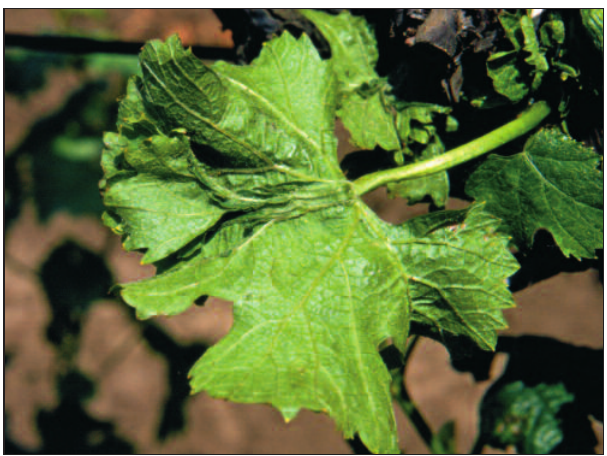
Figure 18. Grapevine enation (GEn) – enations on the underside of the leaves of transmitted Vitis vinifera cv.